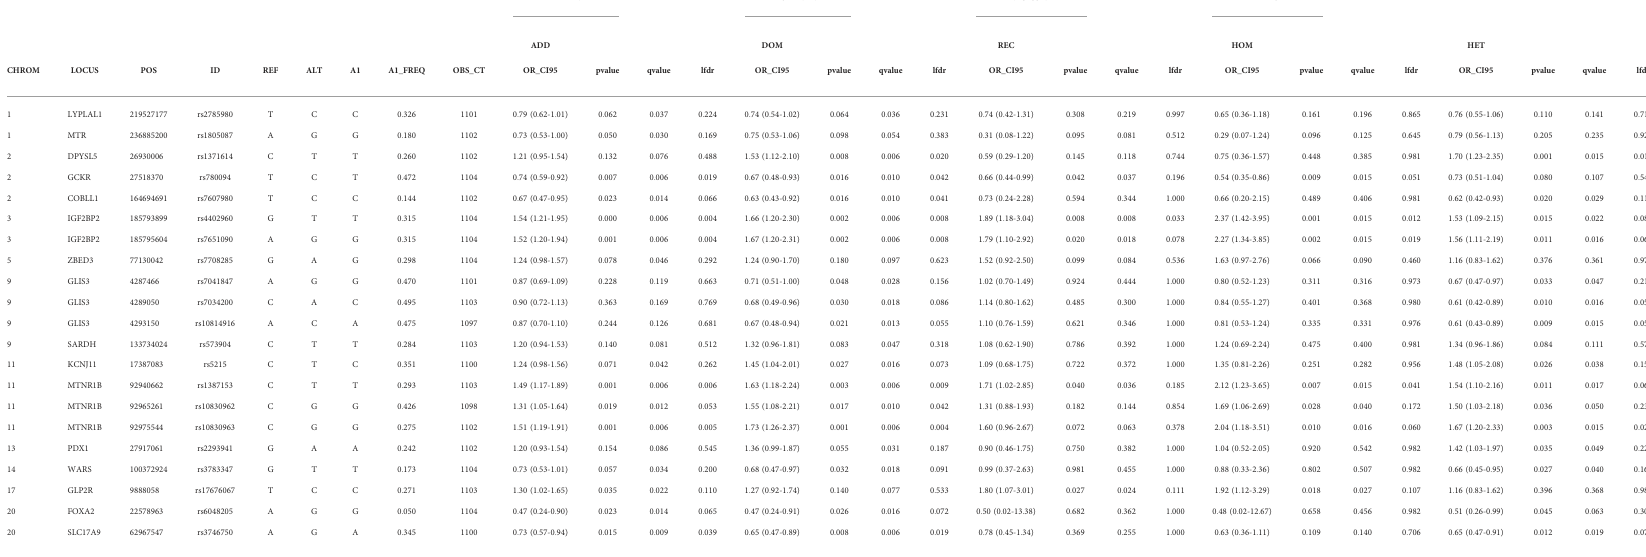
Table that summarizes the most relevant results of the analysis of SNPs + Group models in Caucasian (CAU) ethnicity. ADD, Additive model; DOM, dominant model; REC, recessive model; HETHOM, heterozygous-homozygous model; CHROM, Chromosome code; LOCUS, Locus/Gene; POS, Base-pair coordinate [GRCh38]; ID, Variant ID; REF, Reference allele; ALT, Alternate allele; A1, Counted allele in logistic regression; A1_FREQ, minor allele frequency; OBS_CT, Number of samples in the regression; OR_CI95, odds ratio with 95% con fi dence